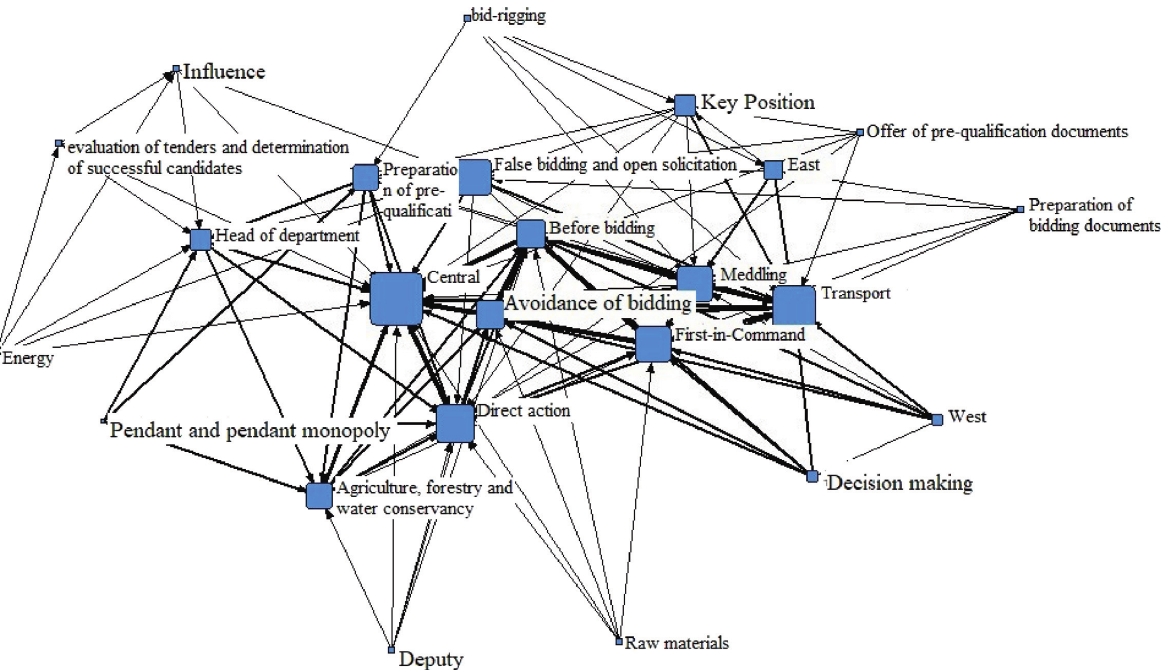
Figure 4: Interventional collusion variable co-occurrence